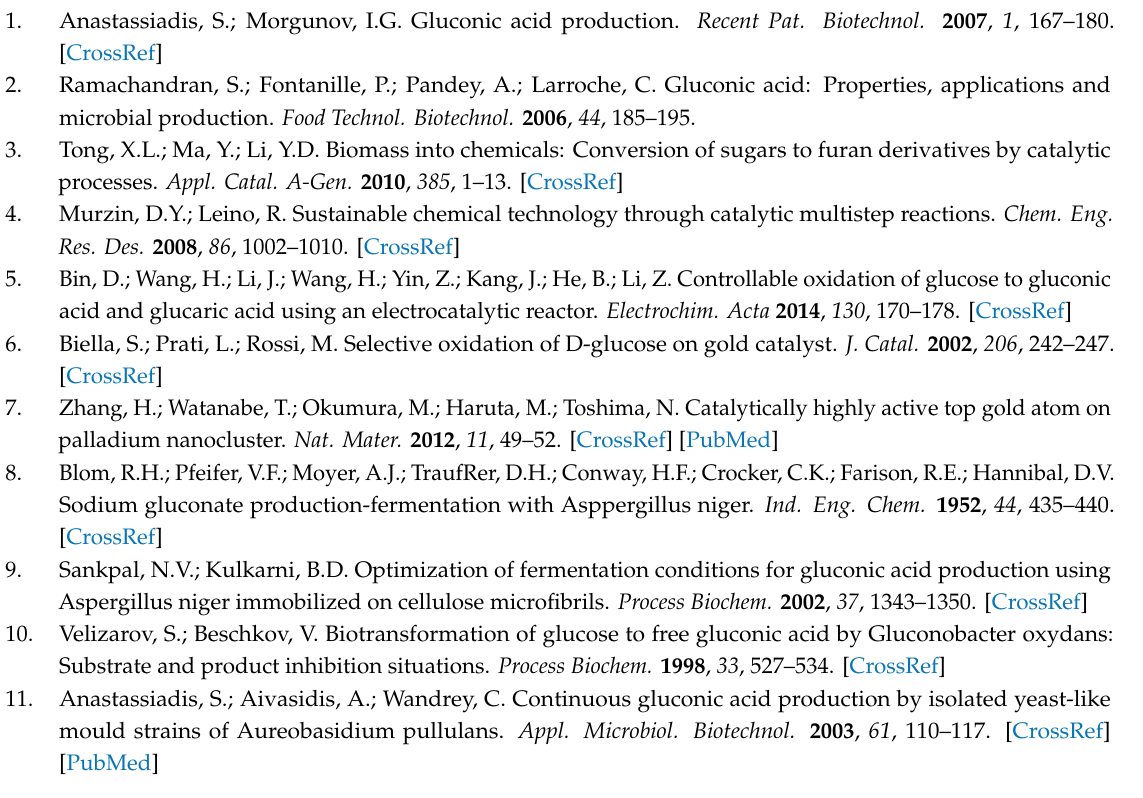
Figure S1: Power curve of the electroenzymatic reactor at 10 mL min − 1 flow rate, 20 mM glucose and O 2 supplied from the gas phase at the cathode side; Figure S2: NMR spectra of lyophilized sample for D-arabinose presentation a) 1H spectra b) 13C spectra; Figure S3: NMR analysis of reaction solutions after 7 h in electroenzymatic reactors tested at three di ff erent flow rates (a) 10 mL min − 1 , (b) 5 mL min − 1 and (c) 2 mL min − 1 ; Figure S4: NMR analysis of reaction mixtures after 7 h of enzymatic electrodes operation in half-cell experiments, (a) and (b), anode at di ff erent potentials; (c) and (d) cathode, at di ff erent potentials, Conditions presented in Table 2; Figure S5: NMR spectra with labeled glucose ( 13 C spectra); Figure S6: NMR results for electroenyzmatic reactors operated at two di ff erent conditions of cell potential and time, 5 mL min − 1 (a) cell potential − 0.1 V, time 16 h and (b) cell potential variation between − 0.1 to 0.05, time 21 h, Conditions presented in Table 3; Figure S7: Polarization curves of Vulcan nanomaterial in the presence and absence of oxygen; Figure S8: Comparison of BOD and GOx-HRP enzymatic electrode obtained in half-cell system, 20 mM glucose, Conditions for BOD-electrode: pH 7.00, 37 ◦ C, for GOx-HRP: pH 6.00, 22 ◦ C; 400 rpm, O 2